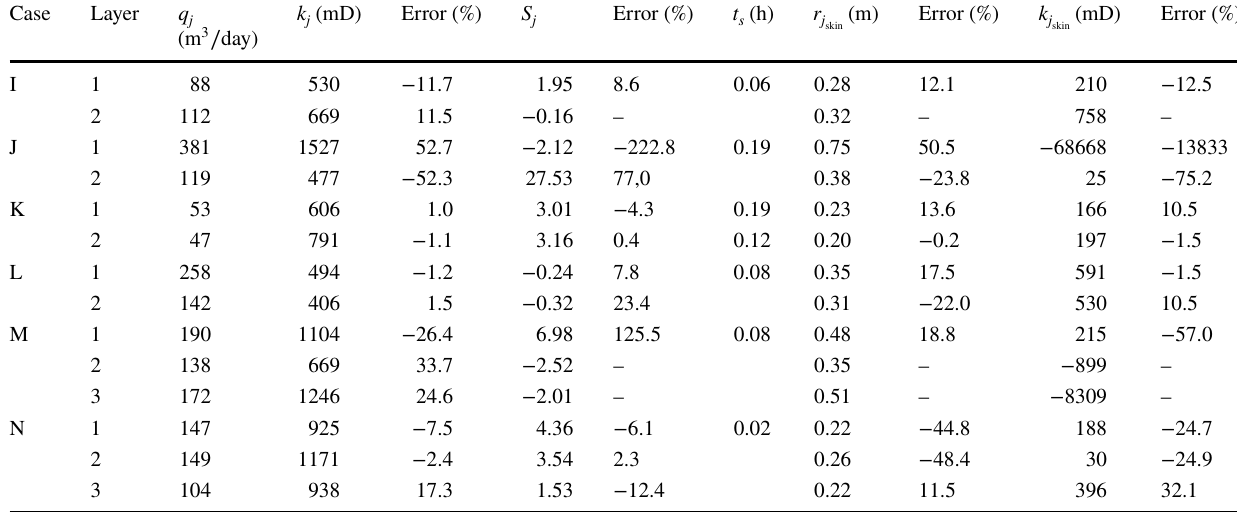
Table 4 Estimated layer properties of the multilayer cases